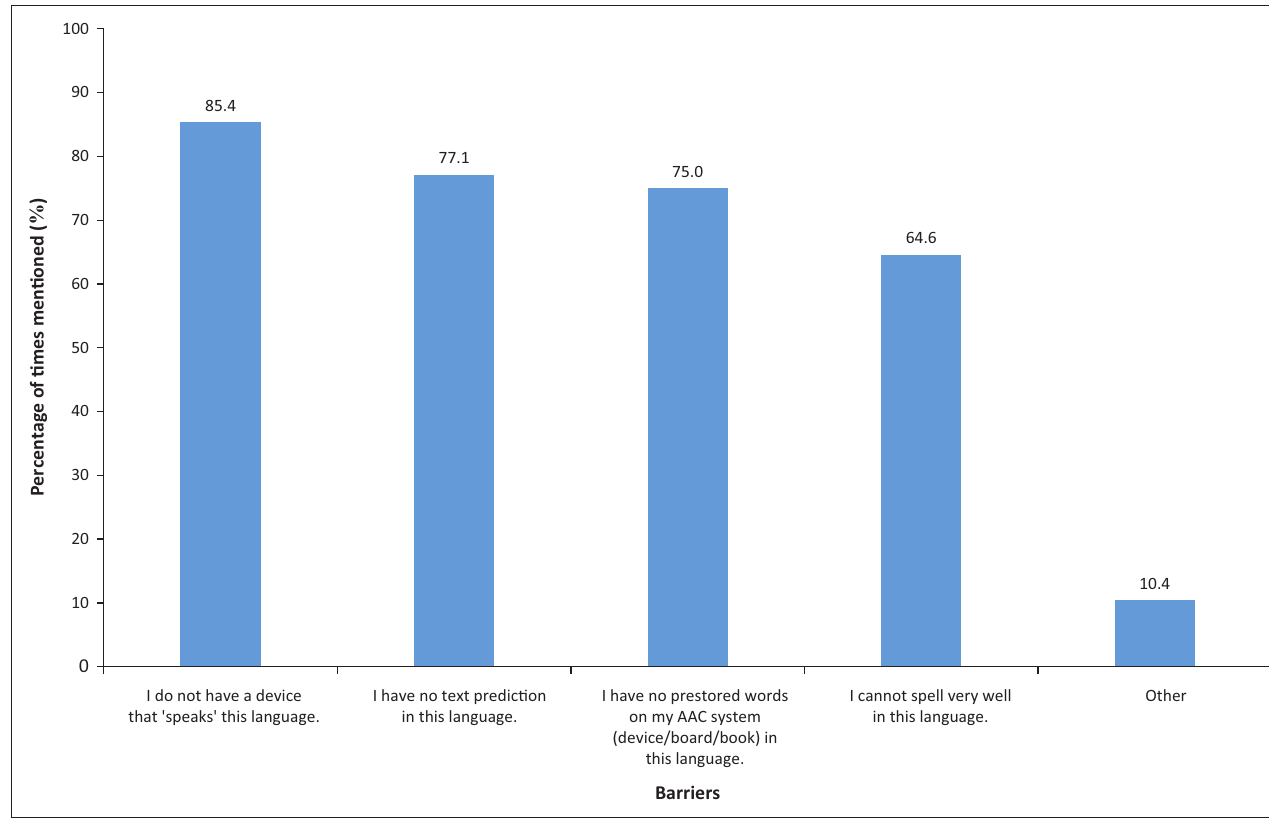
FIGURE 3: Frequency with which specific barriers prevented access to different